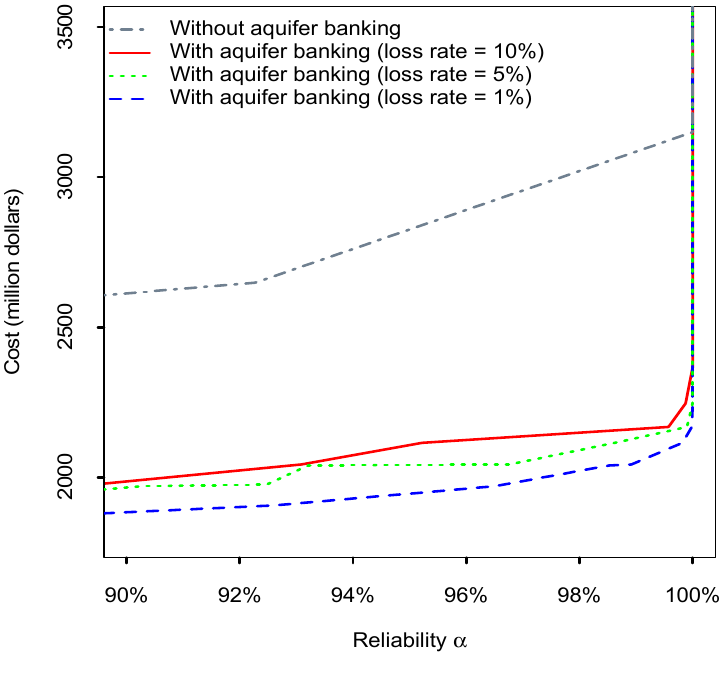
Figure 2 . Optimal pareto fronts of different model scenarios for with- and without water banking and showing the effect of rates of storage depreciation between 1% and 10% per